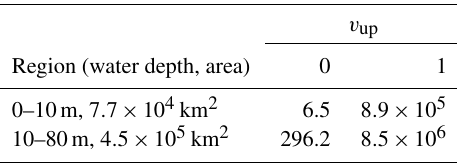
Table 2. Estimated flux of CH 4 at SWI in molyr − 1 for different depth regions of Laptev Sea in a passive ( v up = 0cmyr − 1 ) and ac- tive ( v up = 1cmyr − 1 )